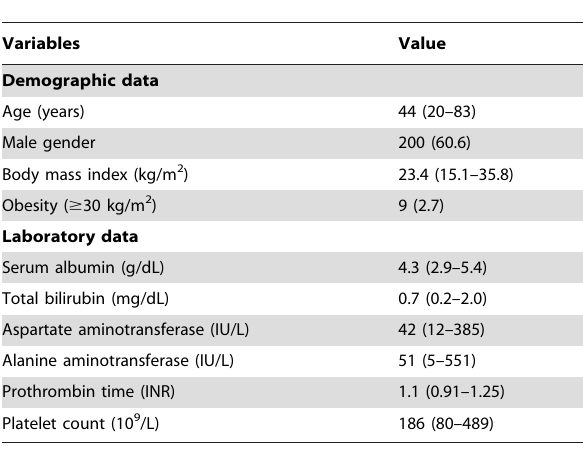
Table 1. Baseline characteristics (n =330).